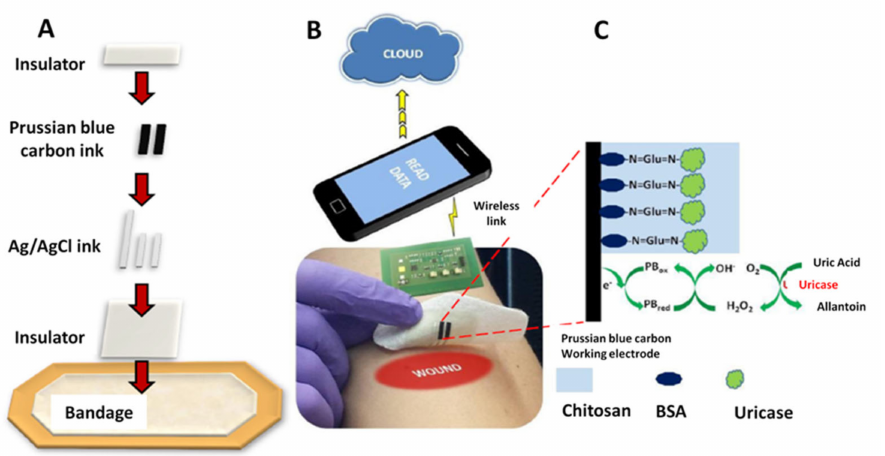
Figure 1. ( A ) Screen printing of the smart bandage. ( B ) Wearable potentiostat used for the operation of the sensor. The analytical signal used for UA detection and quantification is transferred to a computer or Smartphone via the wireless system. ( C ) Schematic representation of amperometric detection of UA with uricase immobilized on Prussian blue (PB) modified working electrode. BSA = bovine serum albumin. Reprinted with permission from Reference [9]. Copyright 2021